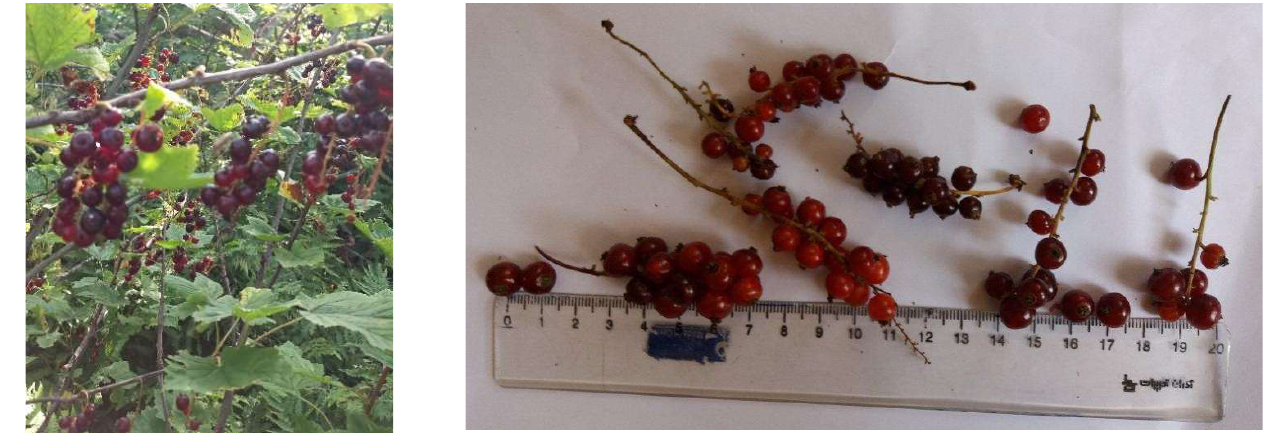
Figure 3. Fruit and leaves of the reddish blackberry ( Ribes biebersteinii ) in Arasbaran forests.